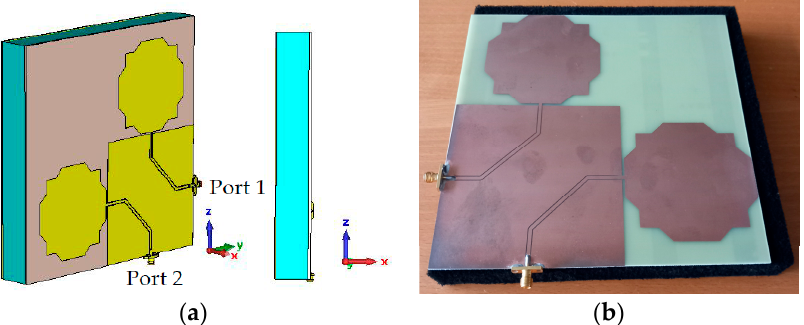
Figure 16. Final monopole antenna configuration. ( a ) CST model. ( b ) Photo of the prototype.